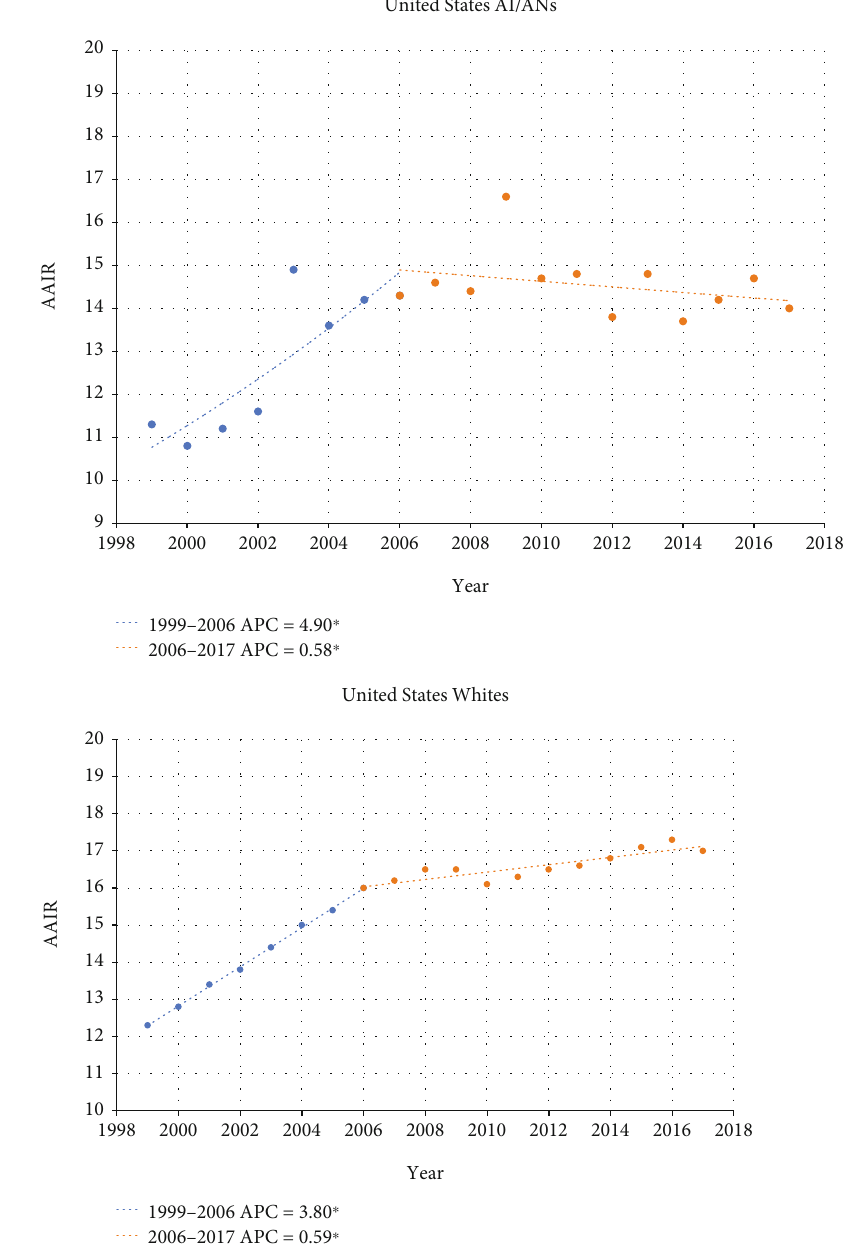
Figure 2: Joinpoint regression comparing AAIR between United States AI/ANs and Whites over time (rates per 100,000 population). ∗ Indicates that the annual percentage change (APC) is signi fi cantly di ff erent from zero at the alpha = 0 : 05